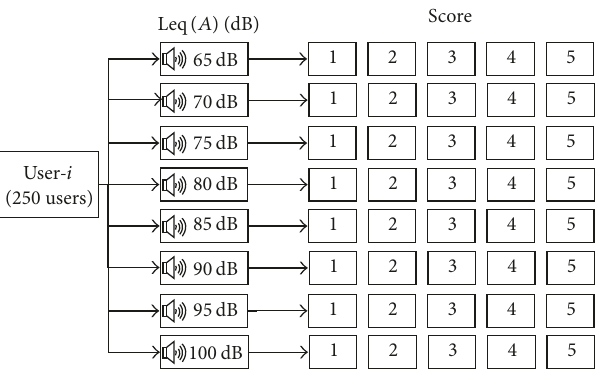
Figure 2: Noise dosimeter WED 007 with microphone, 01 dB.